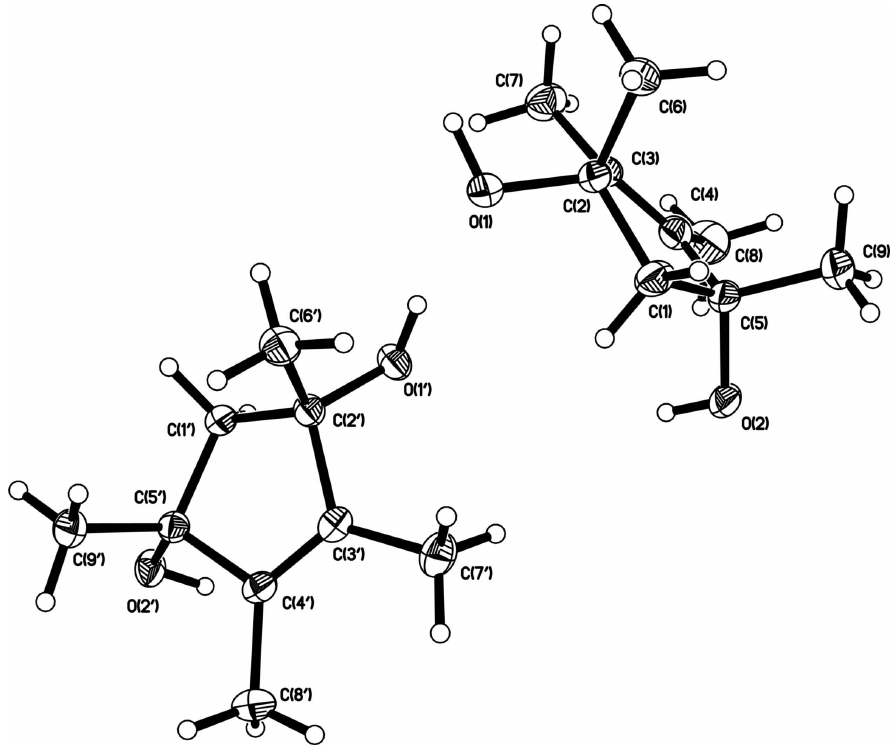
Figure 1 The molecule of the title compound in the crystal. Displacement ellipsoids represent 50% probability levels. H-Atom radii are arbitrary.